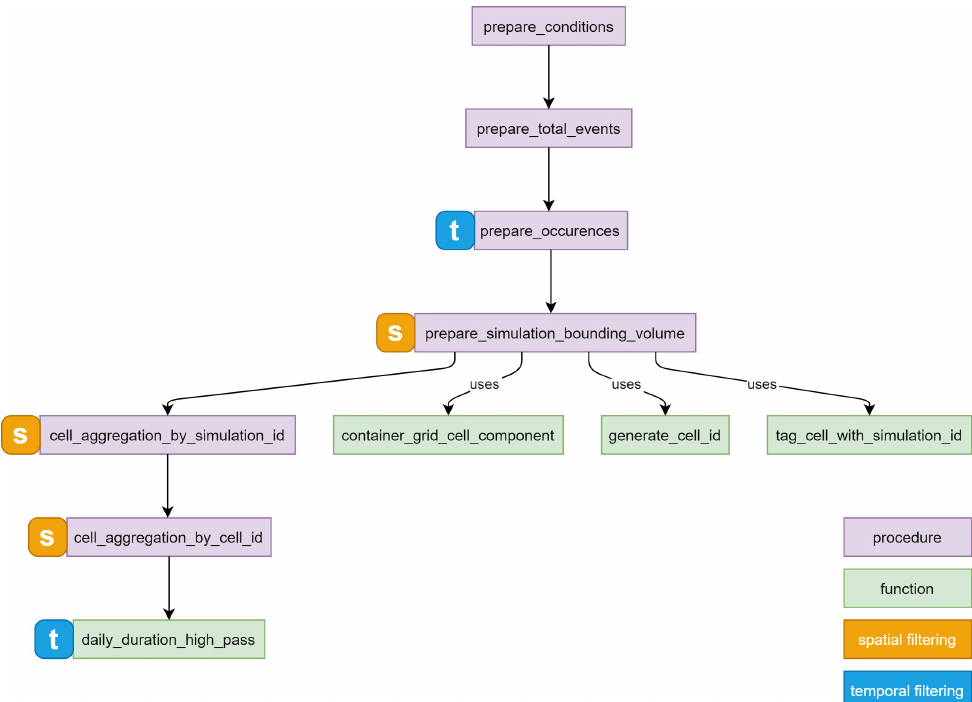
Figure 10. The process flow of the spatio-temporal grid